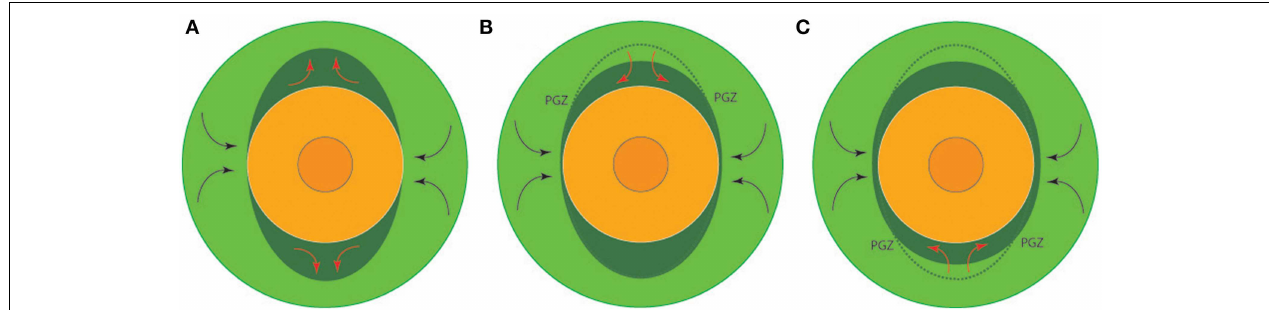
FIGURE 1 | Equatorial cross-sections of the core (orange) and lower mantle (light green) illustrating compositional superplume growth and collapse in the D"-region (dark green) above the core-mantle boundary (CMB). Arrows indicate the implied lower mantle circulation patterns. (A) Superplume growth phase thins the D"-region below lower mantle downwellings, increasing the global mean CMB heat flux and its lateral heterogeneity. The geodynamo responds with higher polarity reversal frequency. (B) One superplume partially